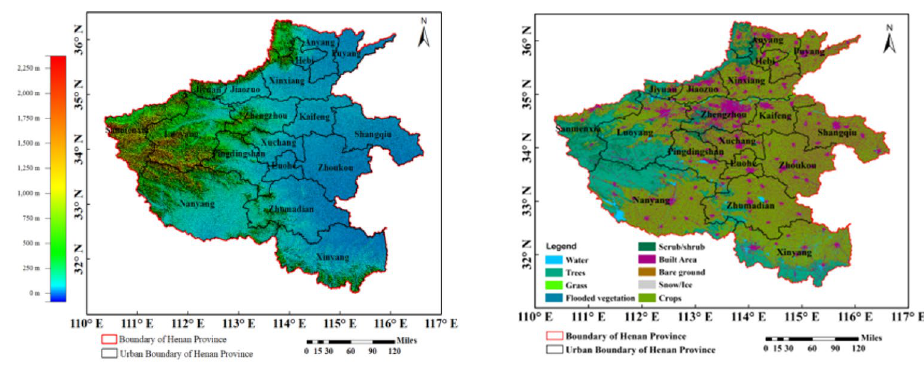
Figure 1. Terrain feature, administrative divisions, and land use / land cover of Henan